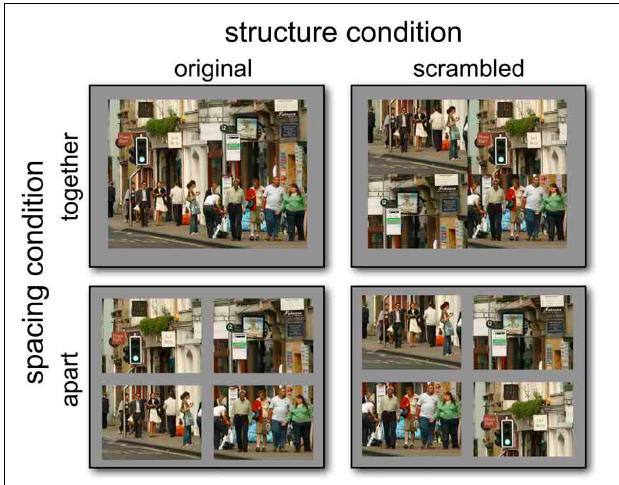
FIGURE 1 | Examples of stimuli from Experiment 1. Stimuli were presented in one of two structure and spacing conditions: four quadrants abutting or spatially apart and four quadrants scrambled or normally